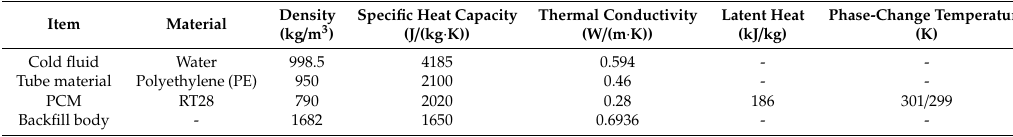
Table 1. The thermophysical